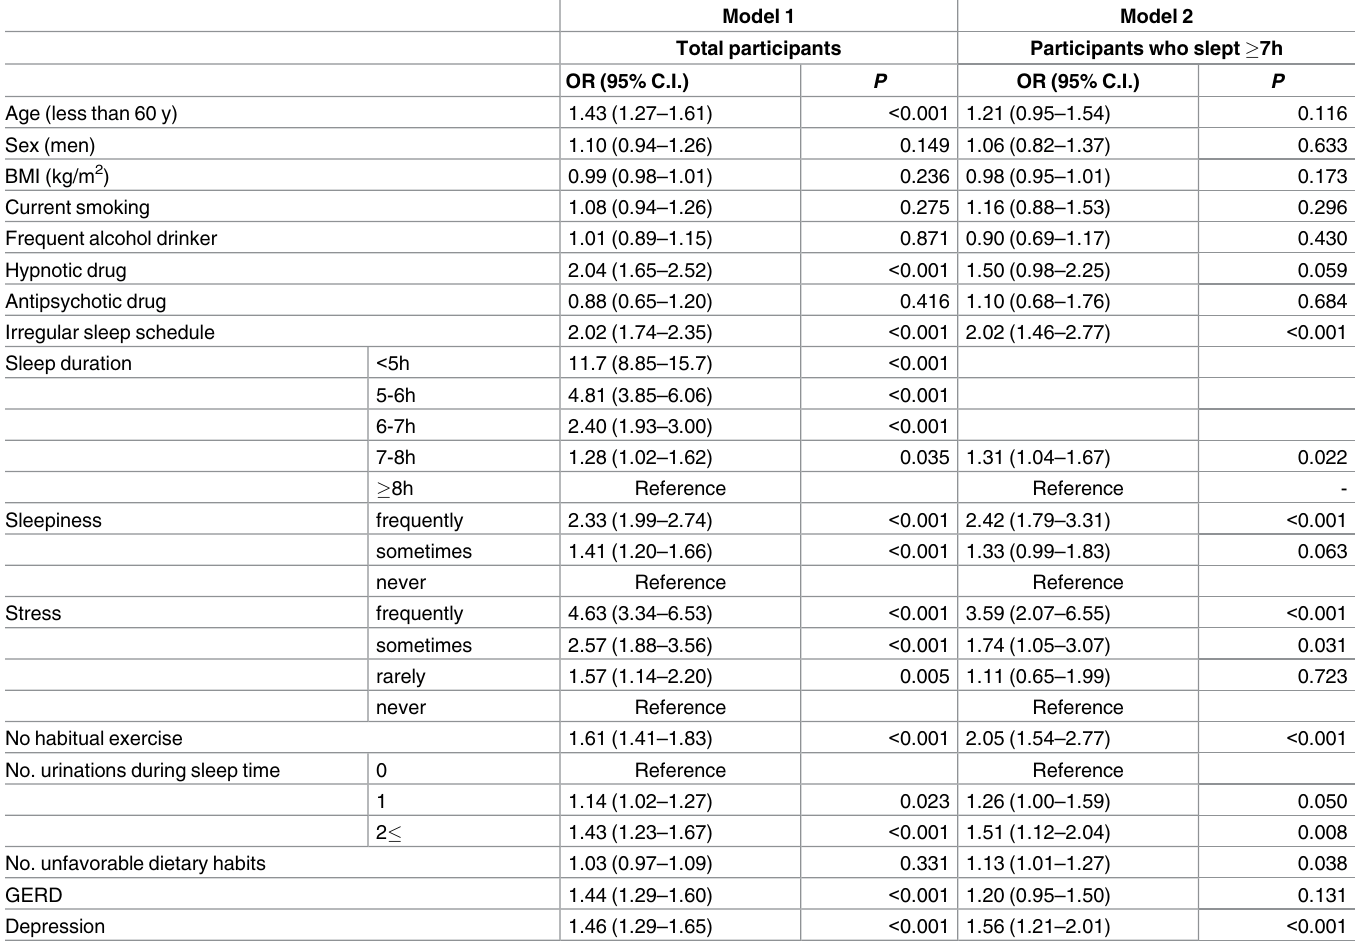
Table 3. Multivariate logistic regression analysis for subjective